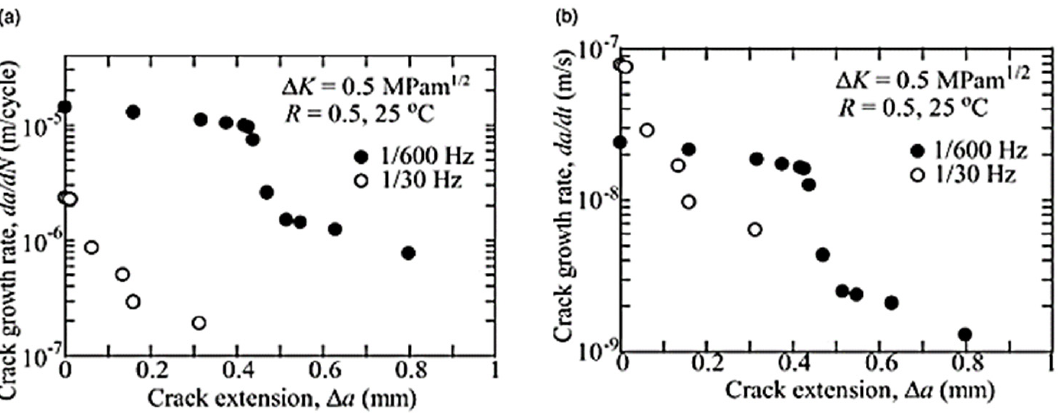
Figure 3. Impact of loading on mode 1 cracking of M4J/2500 laminates in air ( a ) cycle-dependent cracking rate, ( b ) time-dependent cracking rate [35].